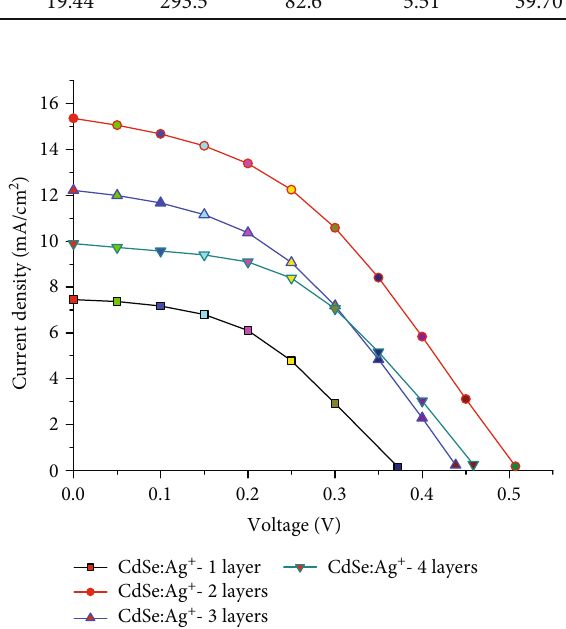
Figure 3: Photocurrent density-voltage (J-V) curves of QDSSCs with di ff erent thickness from 1 layer to 4